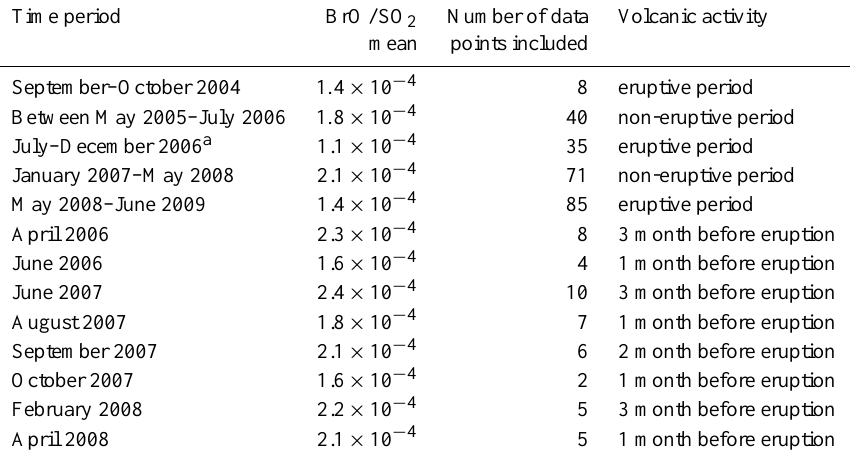
Table 1. Summary of mean BrO/SO 2 values during the various time periods as described in the text. The table also displays the number of data points available for the various time frames.